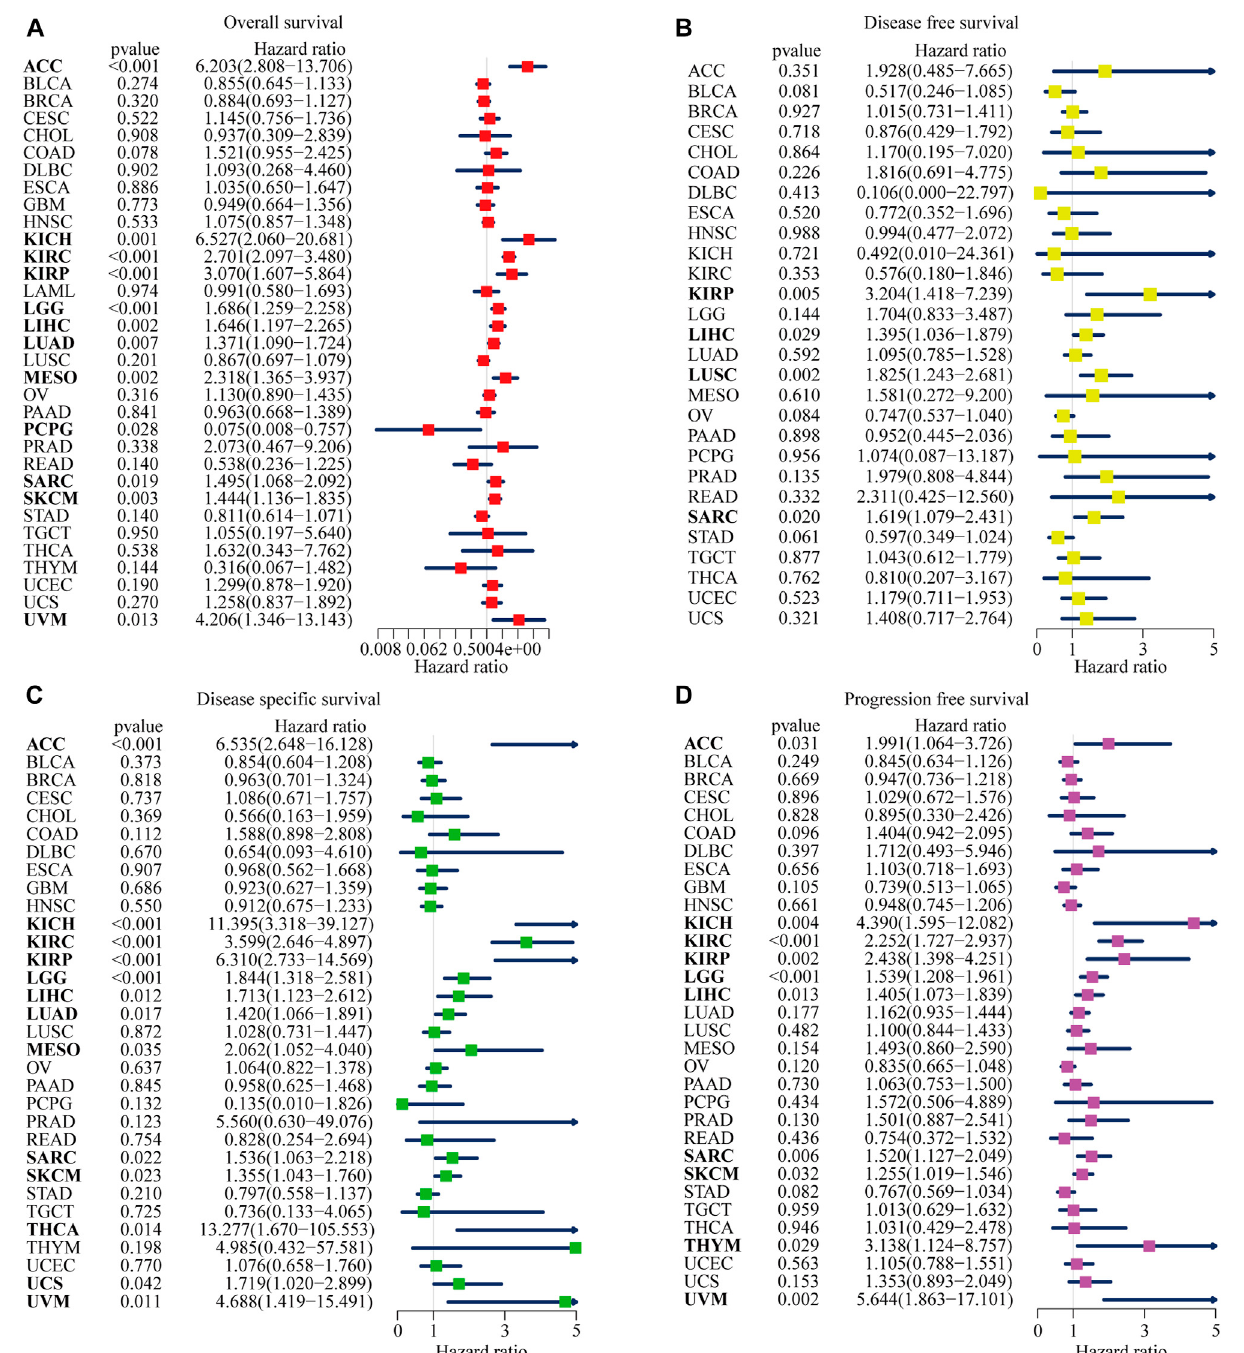
Figure 4 ( p < 0.001 and |R| > 0.3). It should be noted that NOP2 expression was negatively correlated with stromal scores in BRCA (R = − 0.3, Figure 4A ), ESCA (R = − 0.4, Figure 4B ), GBM (R = − 0.57, Figure 4C ), LAML (R = − 0.34, Figure 4D ), LUAD (R =